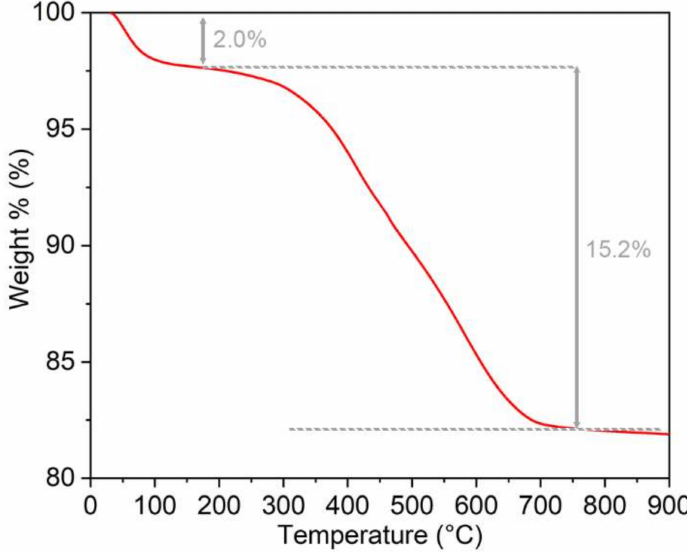
Figure 1. Thermogravimetric analysis (TGA) of QxCav@SiO 2